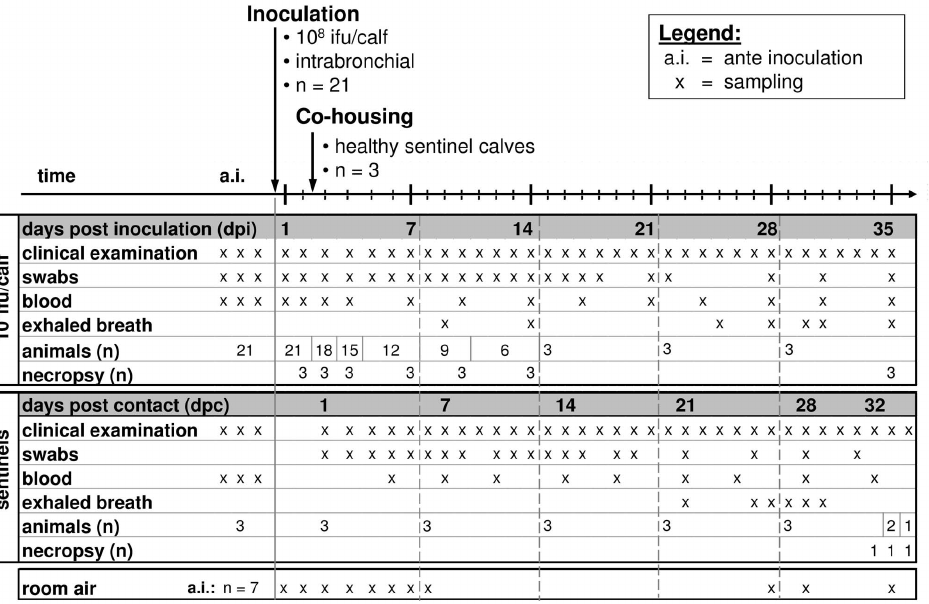
Figure 5. Study design. During this prospective study, three samples were collected before experimental or natural challenge with C. psittaci and hereafter on time points given below the timeline for both study